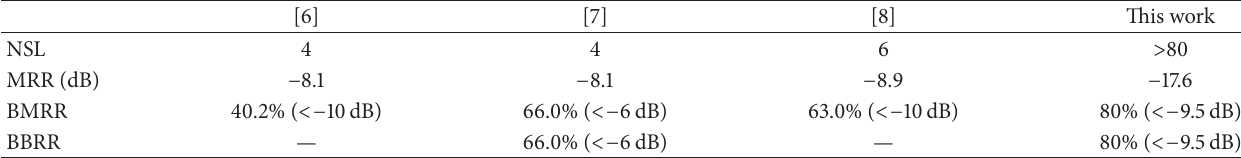
Table 1: Comparisons between the results of this work and earlier checkerboard surfaces.